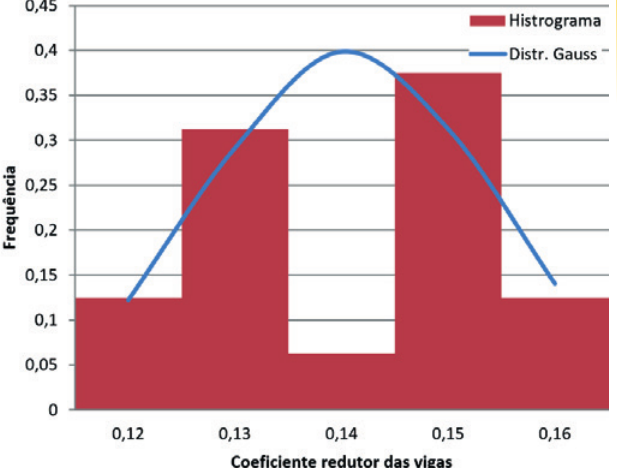
Distribuição de Gauss x Histrograma para a rigidez das vigas nos exemplos com 3